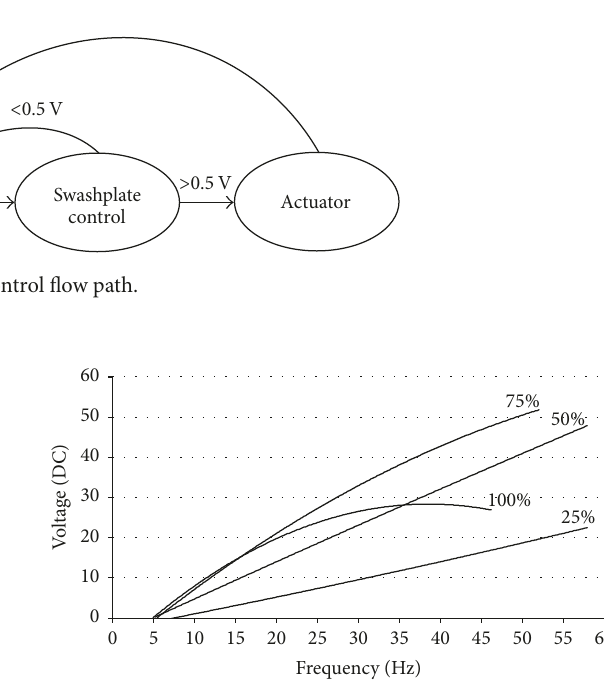
Figure 6: Voltage generation at different swashplate